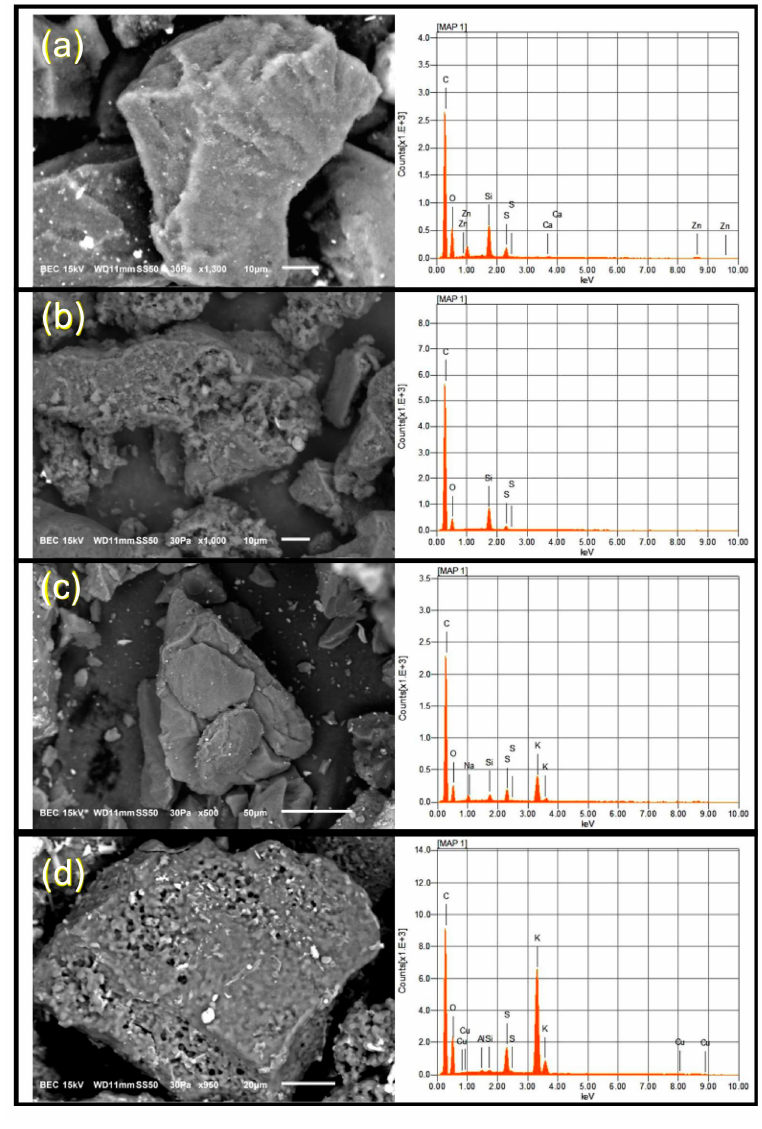
Figure 2. Scanning electron microscopy (SEM) images from ( a ) CB, ( b ) CB.H 2 SO 4 , ( c ) CB.KOH and ( d ) CB.H 2 SO 4 + KOH. The right column shows the energy-dispersive X-ray spectroscopy (EDS) results from each carbon black